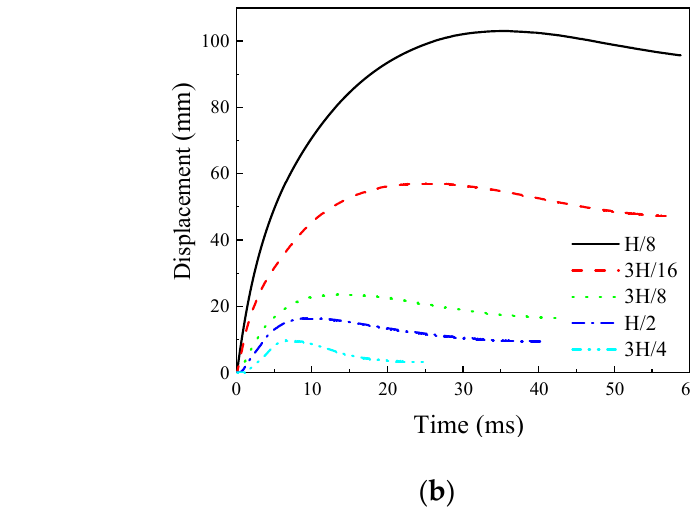
Figure 23. Displacement–time curves of the fabricated shear wall with different explosive distances. ( a ) Without grouting defects. ( b ) With 10% grouting defects. Regarding 10% grouting defects, the displacement–time curves of the shear wall are shown in Figure 23b, and the peak displacement increases to 103.02 mm, 57.08